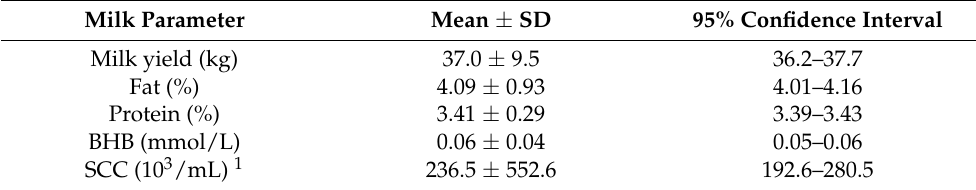
Table 1. Descriptive analysis of milk yield and milk contents from all 610 milk